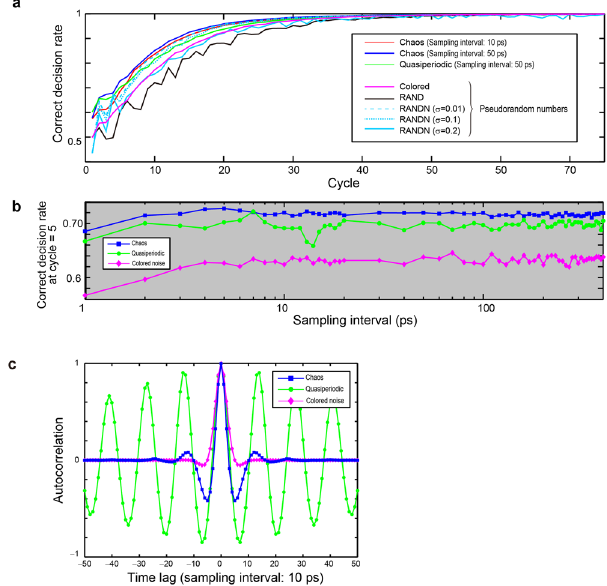
Figure 3. Reinforcement learning from zero prior knowledge. ( a ) Evolution of the CDR with laser chaos signals (sampling interval: 10 and 50 ps), quasiperiodic signals (sampling interval: 50 ps), coloured noise (sampling interval: 50 ps), and uniformly and normally distributed pseudorandom numbers. The CDR exhibits prompt adaptation with laser chaos when the sampling interval is 50 ps. ( b ) The CDR is evaluated as a function of the sampling interval from 10 ps to 400 ps, where the maximum performance is obtained at 50 ps with laser chaos. CDR with chaotic lasers yields superior performances compared to quasiperiodic and coloured noise signals. ( c ) Autocorrelation of the experimentally observed laser chaos, the quasiperiodic signal trains, and numerically generated coloured noises. The chaotic signals exhibit the negative maximum when the time lag is 5 or − 5, exactly coinciding with the fact that the optimal adaptation is realized at 50-ps (10 ps × 5) sampling